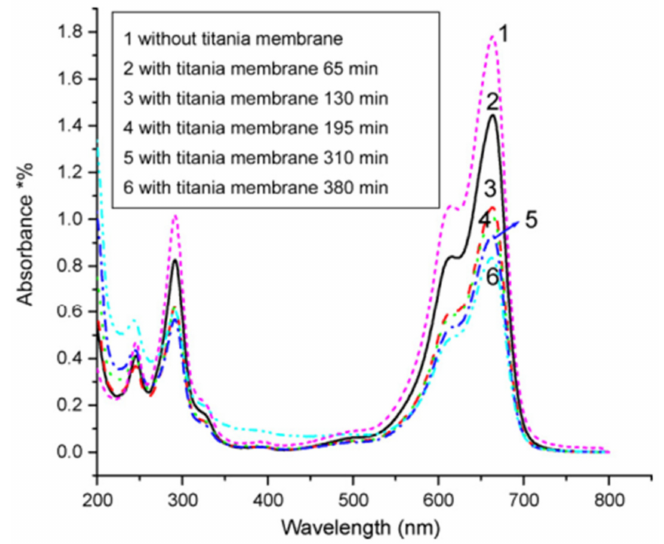
Figure 3. UV-VIS absorption spectra of MB with and without titania membrane (MB spectrum 1 without titania membrane, pink color) in the range of 200–800 nm [58].